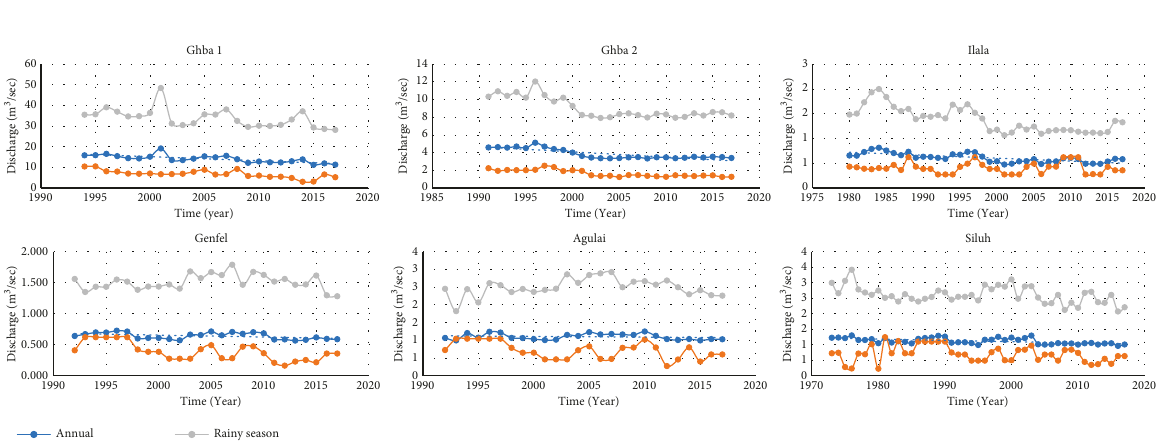
Figure 8: The annual river discharge of Ghba subbasin at six stations.